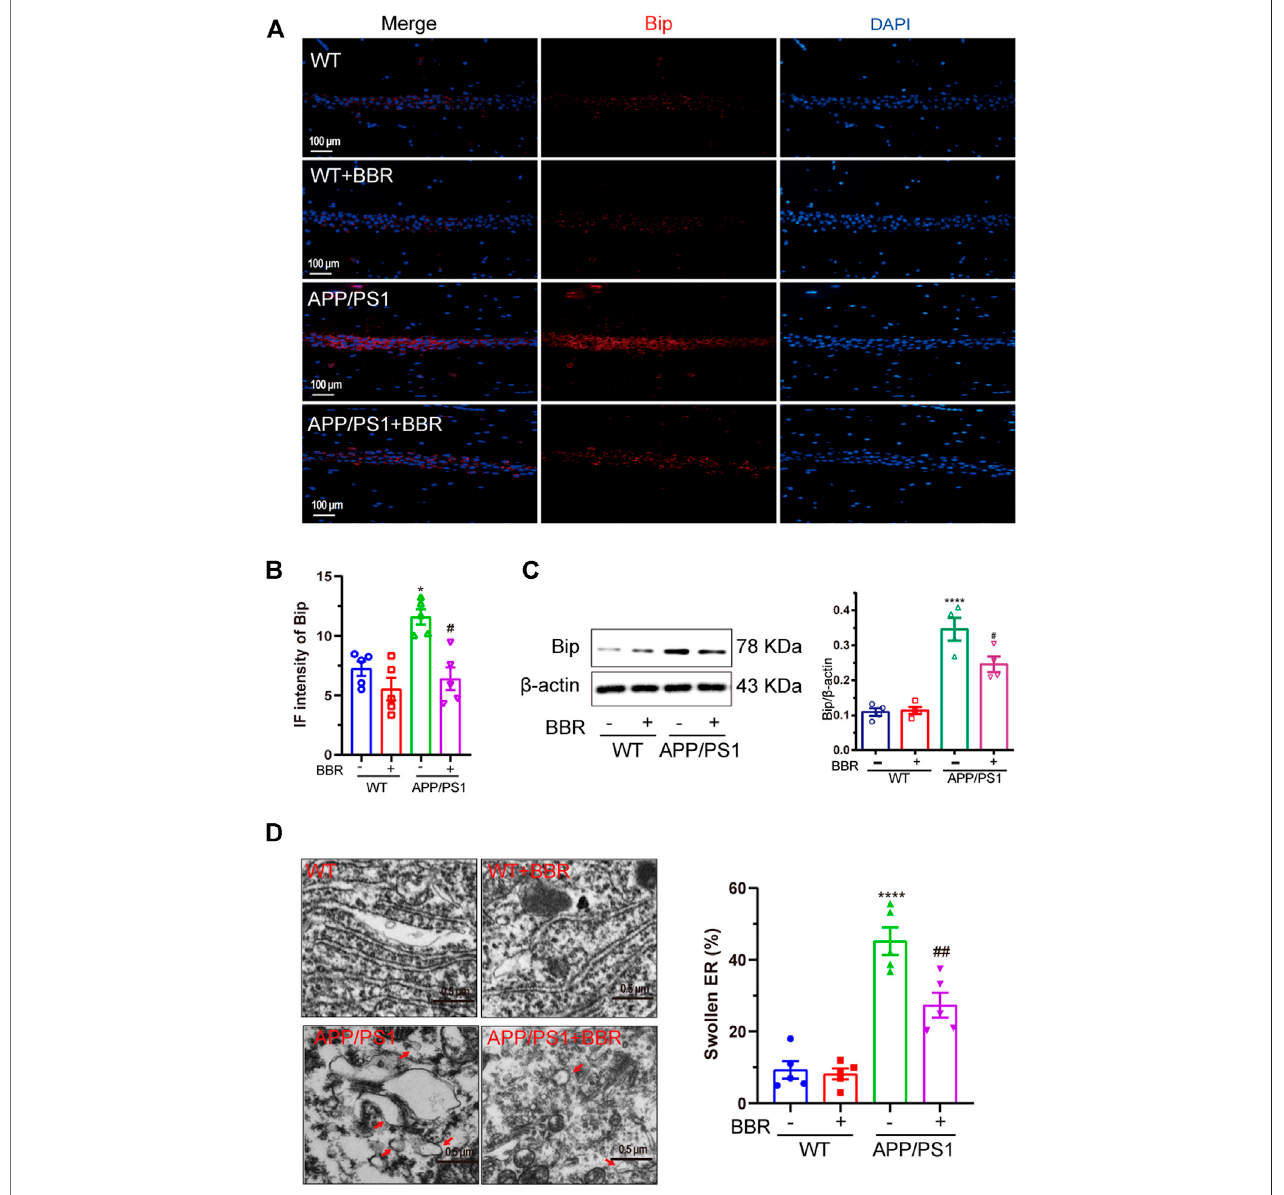
FIGURE 1 | Berberine alleviates ER stress in APP/PS1 mice. (A) Representative immuno fl uorescence images of Bip in the CA1 region of the hippocampal tissue sections.Scalebaris100 μ m. (B) Quanti fi cationofIFintensityofBip. (C) WesternblotdetectionofBipexpressioninthehippocampaltissuesofthemiceandquantitative analysis. (D) RepresentativeTEMimagesoftheendoplasmicreticulumstructure intheCA1regionofhippocampal tissuesandquantitativeanalysis.Scalebaris0.5 μ m. Data were presented as means ± SEM. **** p < 0.0001 vs. WT; # p < 0.05, ## p < 0.01 vs. APP/PS1 without BBR.